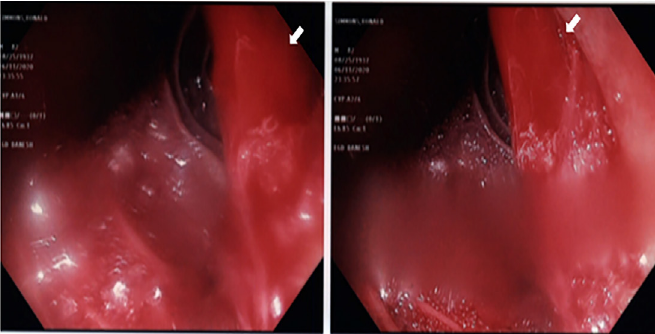
Image 2. Endoscopy images of active arterial bleeding (white arrow) from submucosal duodenal pseudoaneurysm that caused a massive gastrointestinal